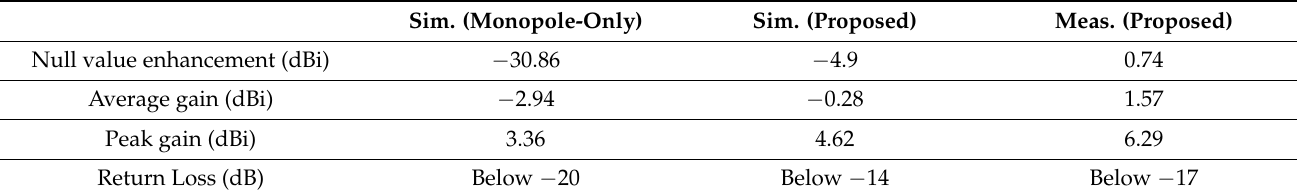
Table 1. Comparison of simulated and measured results. Sim. (Monopole-Only) Sim. (Proposed) Meas. (Proposed) Null value enhancement (dBi) −